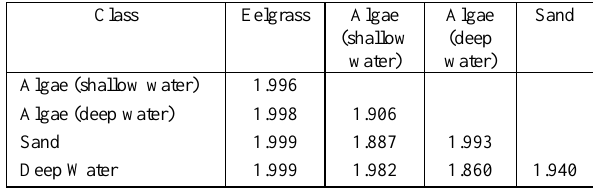
J–M distances computed with all the 5 bands of the UAV image